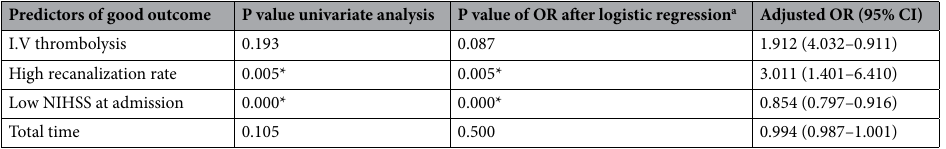
Table 3. Multivariate logistic regression of variables affecting good 90 days clinical outcome. OR odds ratio, CI confidence intervals. *Means statistically significant. a Goodness-of-fit was measured by Hosmer–Lehmeshow parameter (P value >